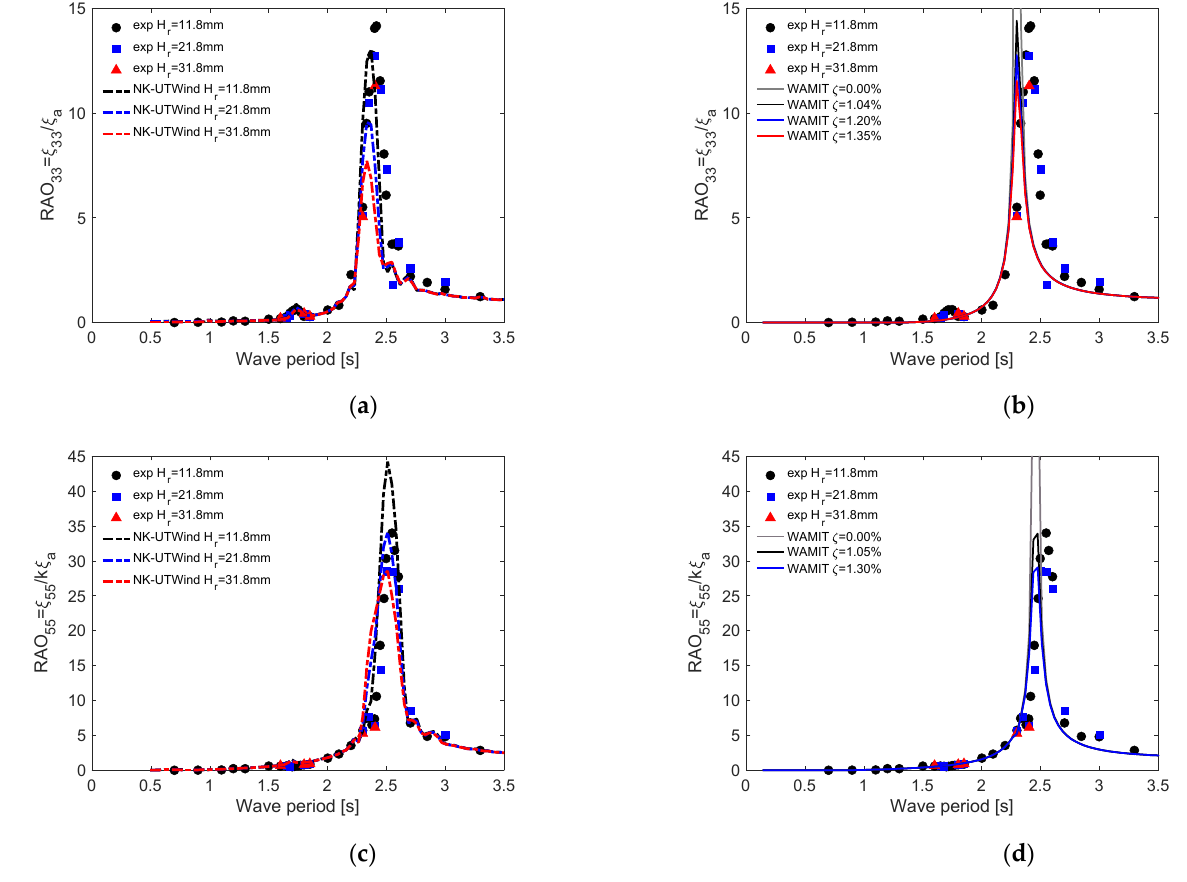
Figure 11. Response amplitude operator (RAO) result comparisons between the experiment and numerical calculations for the Sphere model and different wave heights: ( a ) heave, NK ‐ UTWind, ( b ) heave, WAMIT, ( c ) pitch, NK ‐ UTWind, and ( d ) pitch, WAMIT code calculations.